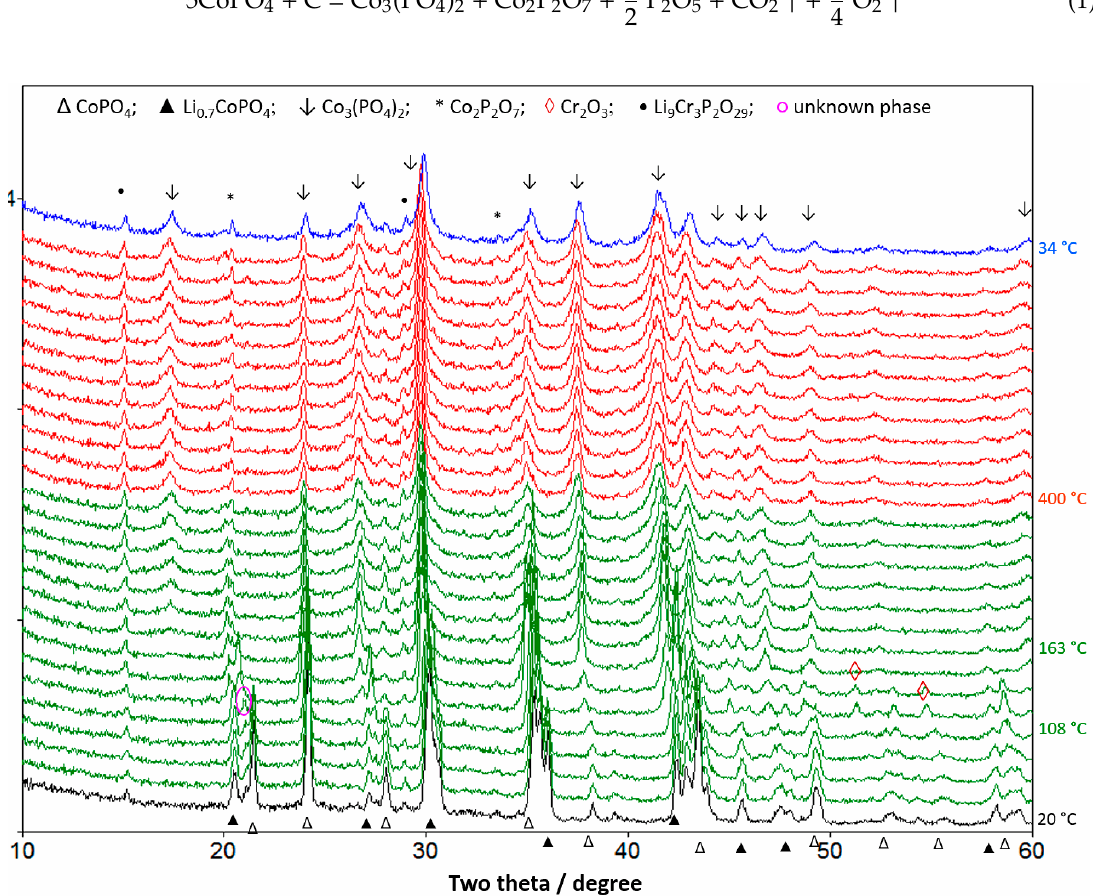
Figure 6. In situ XRD patterns of the delithiated LCP under N 2 upon heating from 20 to 400 °C and subsequent cooling from 400 to 34 °C at a heating rate of 5 °C min − 1 .